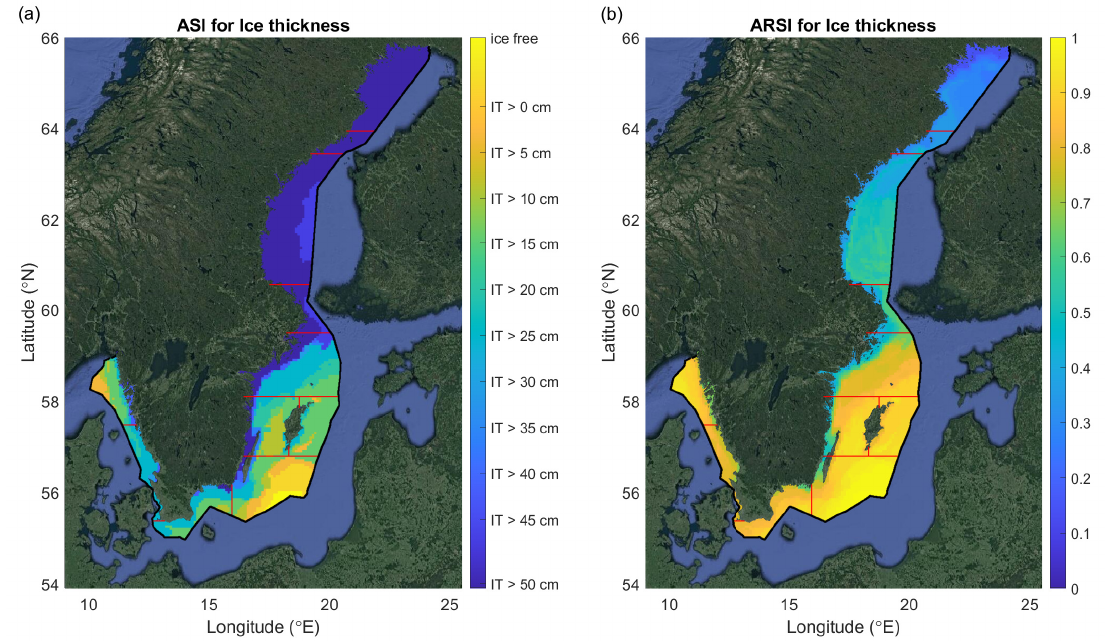
Figure 7. The Average Suitability Index (ASI) for Ice Thickness (IT) based on considering any presence of ice thickness categories (in ( a )) represents the presence of their maximum ice thickness category over 34 years. The percentile limits are used to formulate the Average Relative Suitability Index (ARSI) in ( b ), which takes into account the amount of time of various ice thickness categories. A value of one indicates ice-free or non-critical ice thickness conditions for all categories considered, and low values imply the presence of potentially critical ice thickness conditions for many of the categories considered. Sub-basin borders following Figure 1 are marked with red